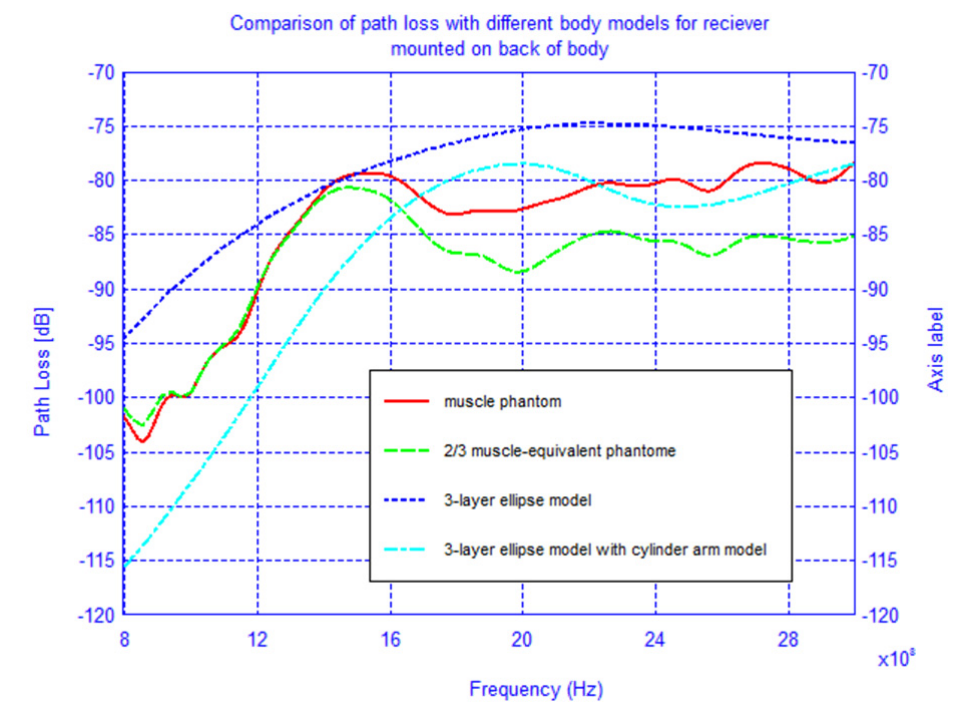
Figure 21. Comparison of the path loss for different phantom models with receiving antenna on the back of the body and transmitting antenna at the waist.